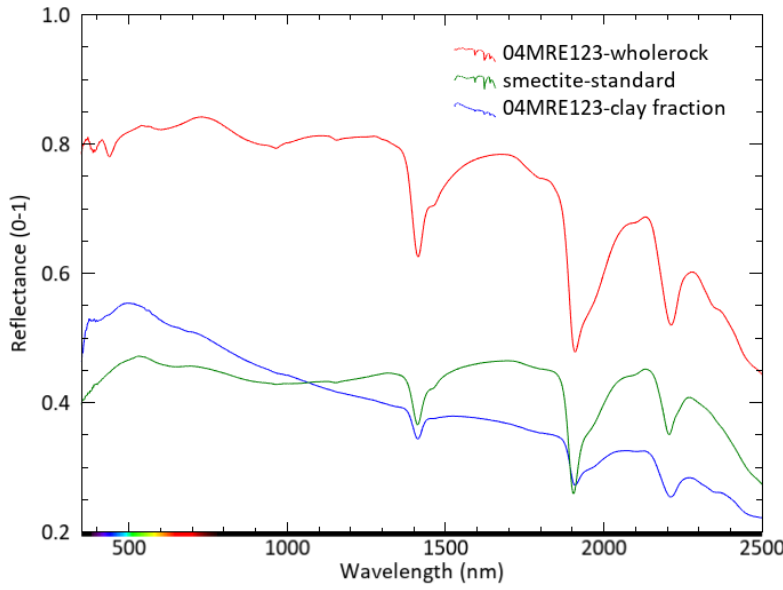
smectite Figure 8. Reflectance spectra of the intact whole-rock sample 04MRE123, its clay fraction and a smectite standard.